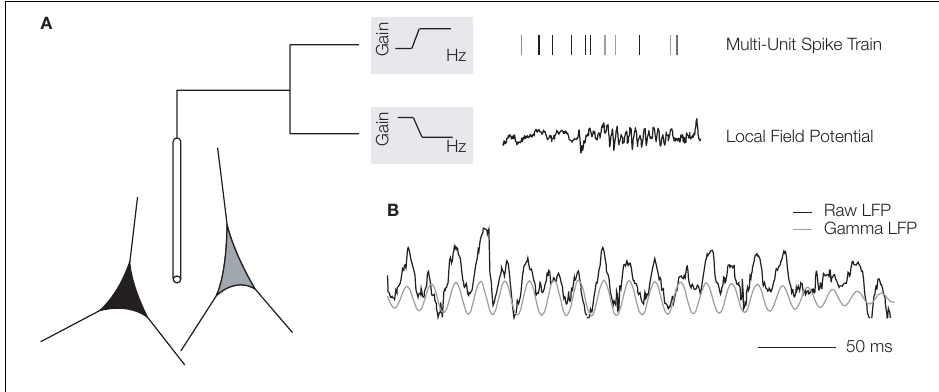
Figure 1 | (A) An extracellular electrode placed in the brain measures the mean extracellular fi eld potential, an aggregate signal originating from the population of neurons in the vicinity of the electrode tip. To obtain multi-unit spiking activity, the recorded voltage trace is high-pass fi ltered and individual action potentials are detected (top). The local fi eld potential (LFP) is comprised of the low frequency components of the extracellular fi eld potential up to 200 Hz (bottom). Its frequency composition varies over time. In the example shown here, prominent oscillations in the frequency band between 30 and 90 Hz – called the gamma-band – are visible during the later part of the trace. (B) In primary visual cortex of awake primates, oscillations in the gamma-band of the local fi eld potential are dominant during visual stimulation, as illustrated in the example. The raw signal (black) has been fi ltered in the gamma frequency range to obtain the gamma LFP